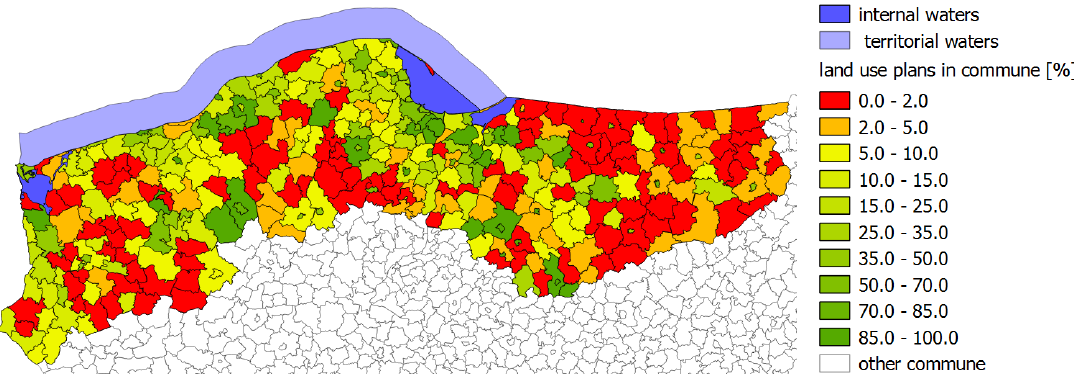
Figure 8. Local land use plans in the municipalities. Source: prepared by the author based on State Register of Borders and [55].